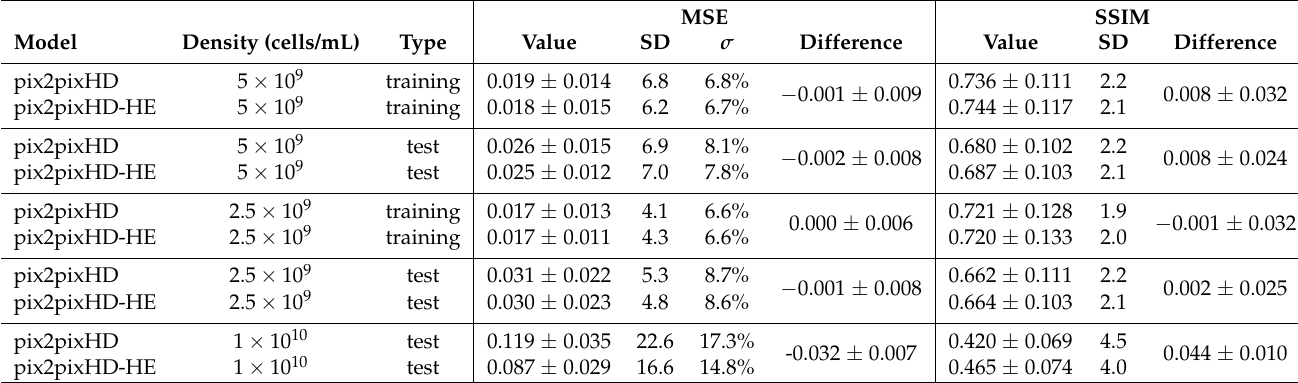
Table 1. Model performance. SD—spatial displacement/ µ m; σ —minimal standard deviation for added Gaussian noise, given as a percentage of original intensity scale.